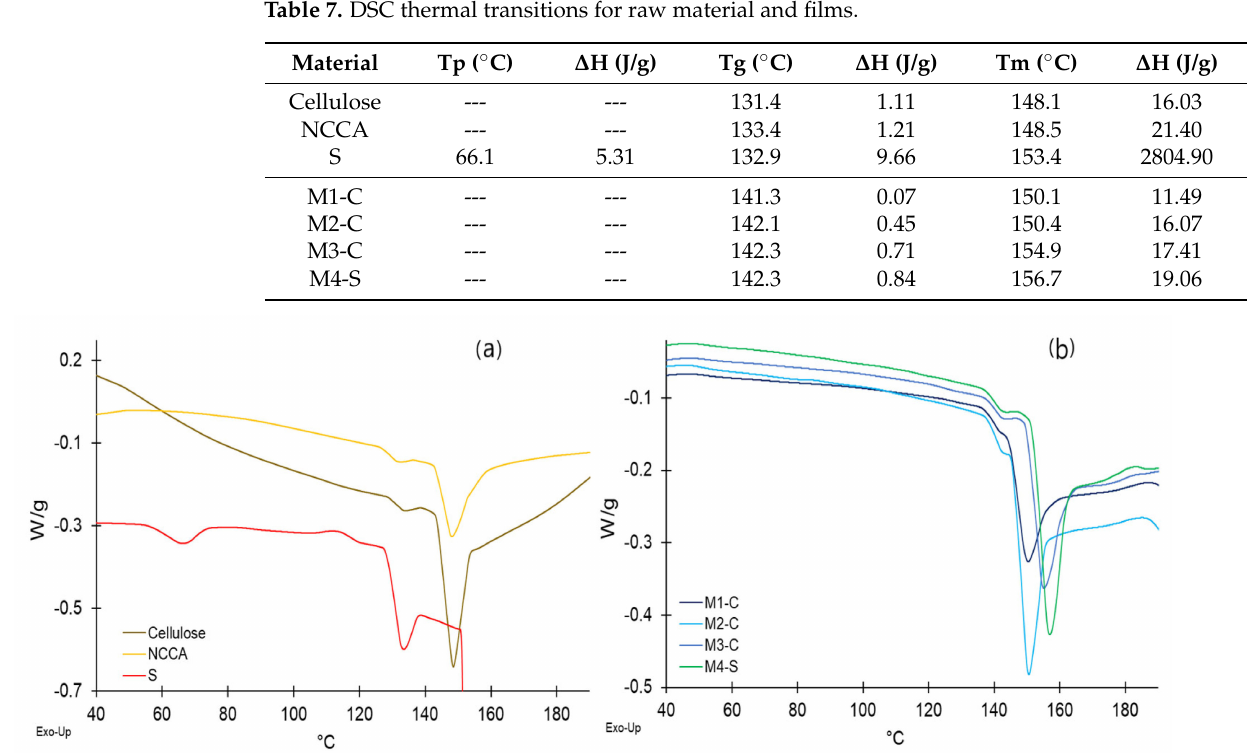
Figure 8. DSC thermogram, ( a ) raw materials, ( b )